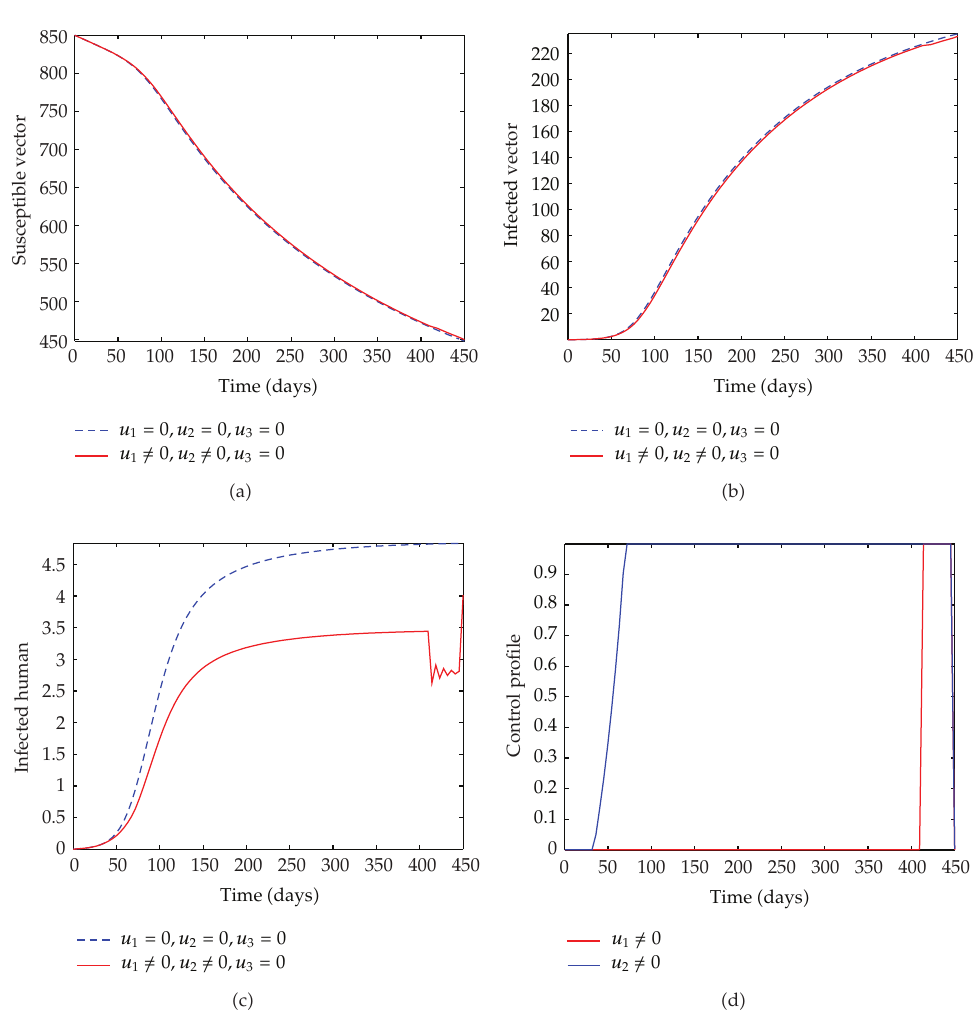
Figure 1: Simulations of the malaria model showing the e ff ect of control strategies on malaria